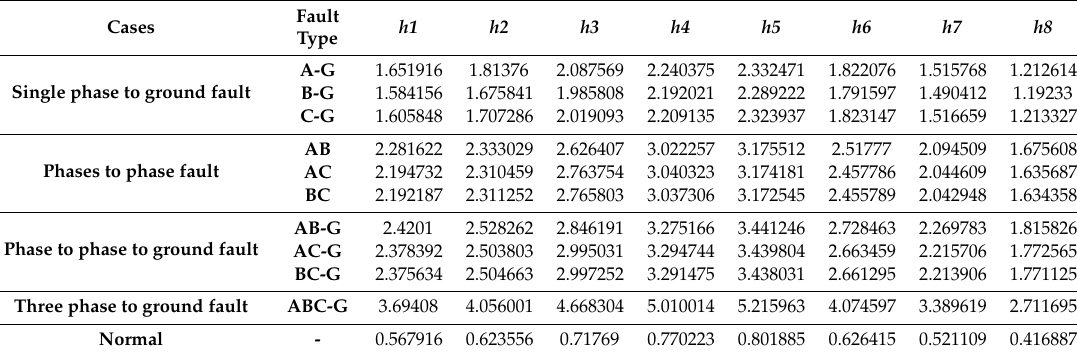
Table 2 indicates the new entropy results for all measured signals under noisy conditions. A White Gaussian Noise was applied to the abovementioned cases, where the signal to noise ratio SNR was 20